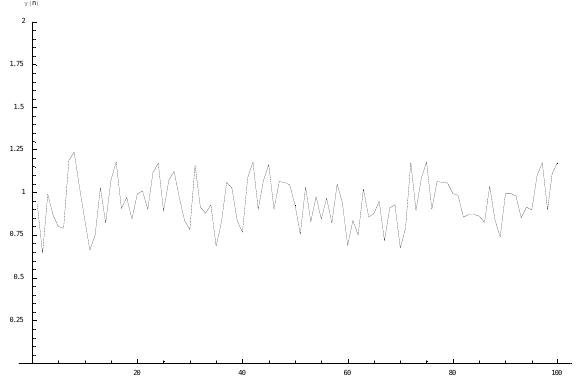
Fig. 12. Cycle-to-cycle evolution of the parameter γ n , modeled by the nonlinear mapping φ . The horizontal time range spans the pe- riod